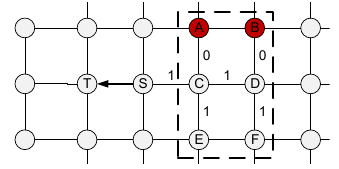
Figure 6. Hotspot information propagated with head flit.